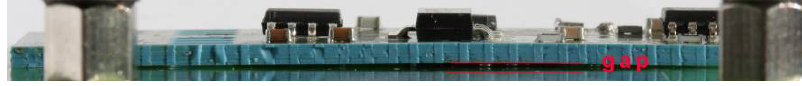
Figure 11. Side view of integrated sensor mounted on PCB depicting convex sensor bending. Note the gap in the middle, which yields a camber of ~0.4